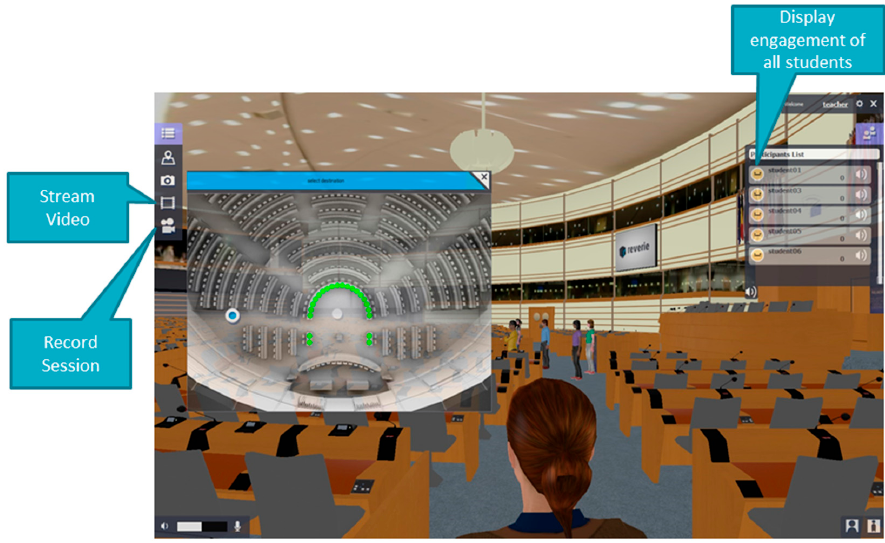
Figure 4. Level of engagement displayed on the GUI.